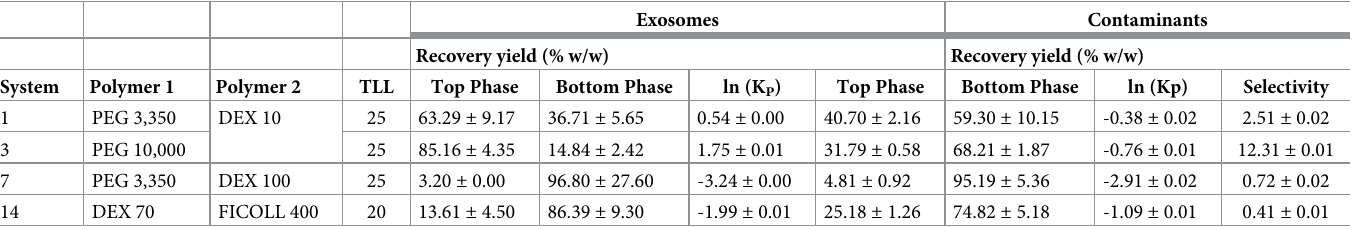
Table 3. Effect of polymer composition, molecular weight (MW) and tie-line length (TLL) upon the partition coefficient, recovery yield and selectivity of exosomes and contaminants in each aqueous two-phase system to reach a final concentration of 25 mM